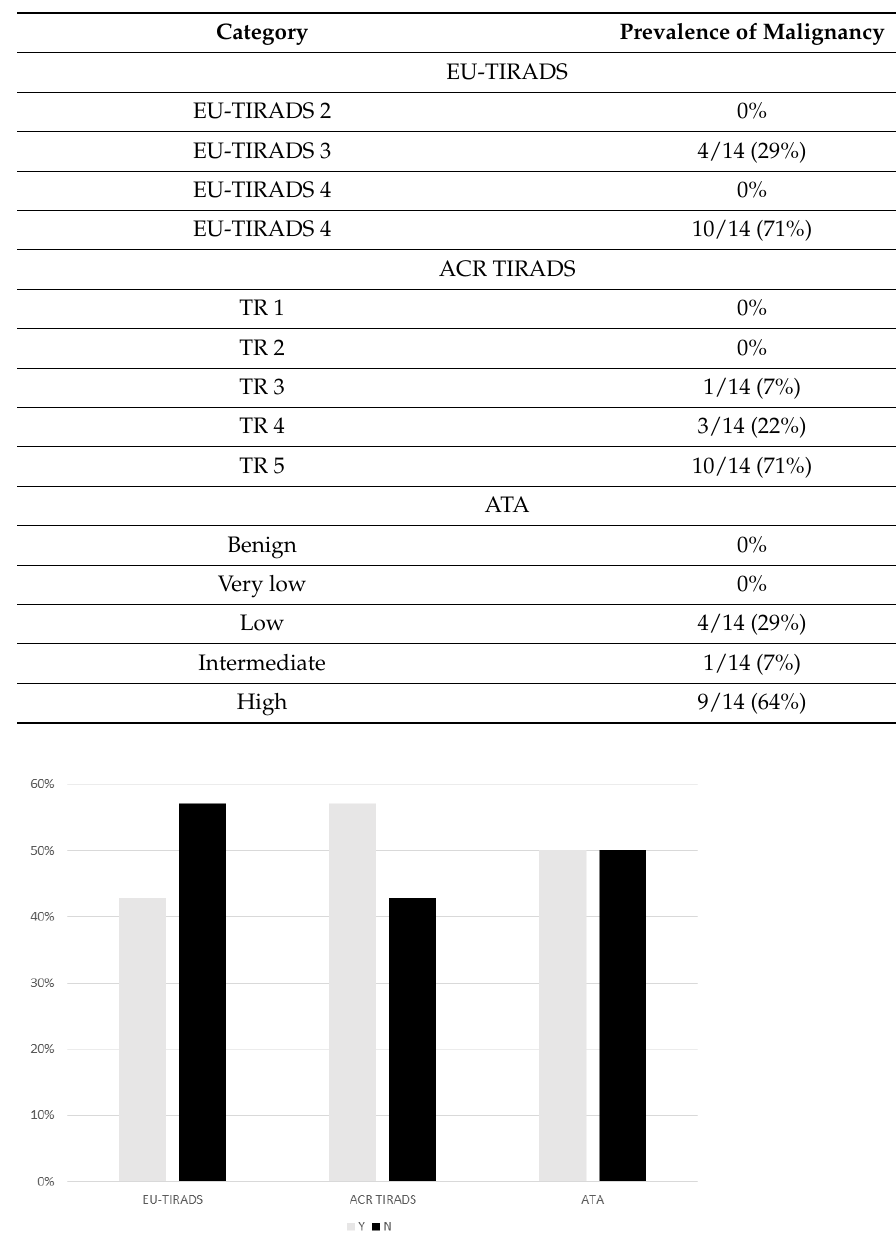
Figure 3. Indication for fine-needle aspiration (FNA) cytology in papillary thyroid cancers according to the criteria set by the 3 US-RSSs